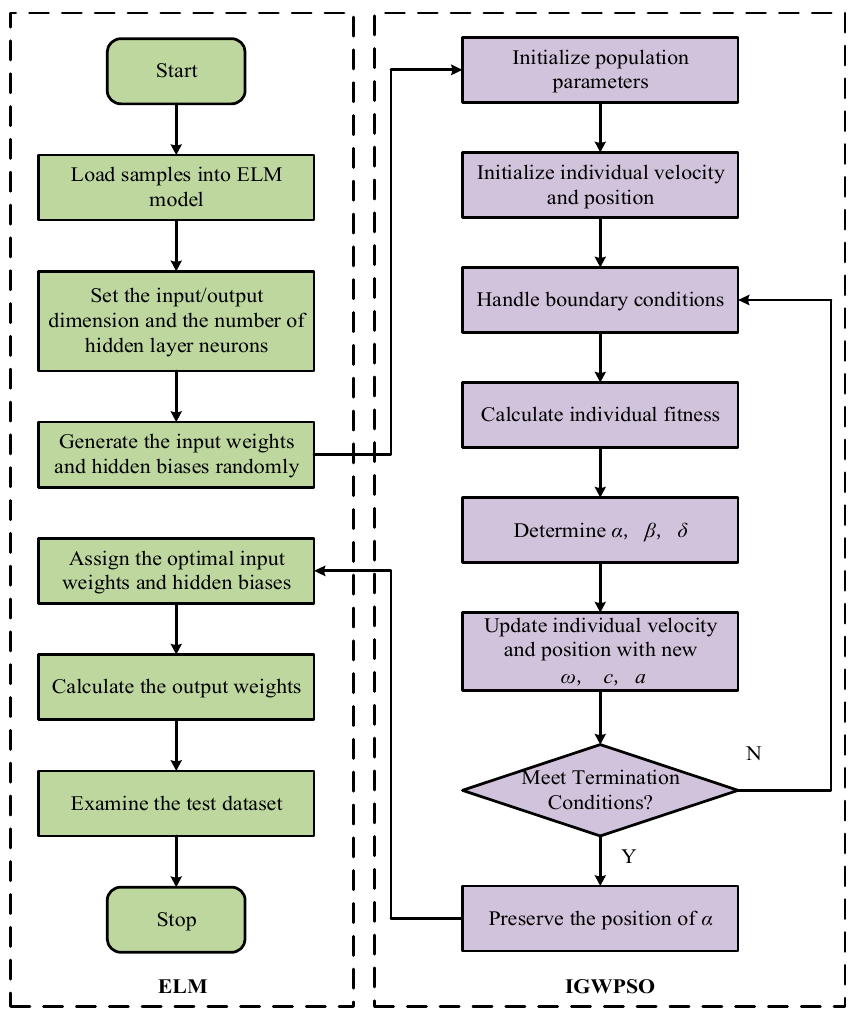
Figure 7. The flowchart of IGWPSO-ELM algorithm.